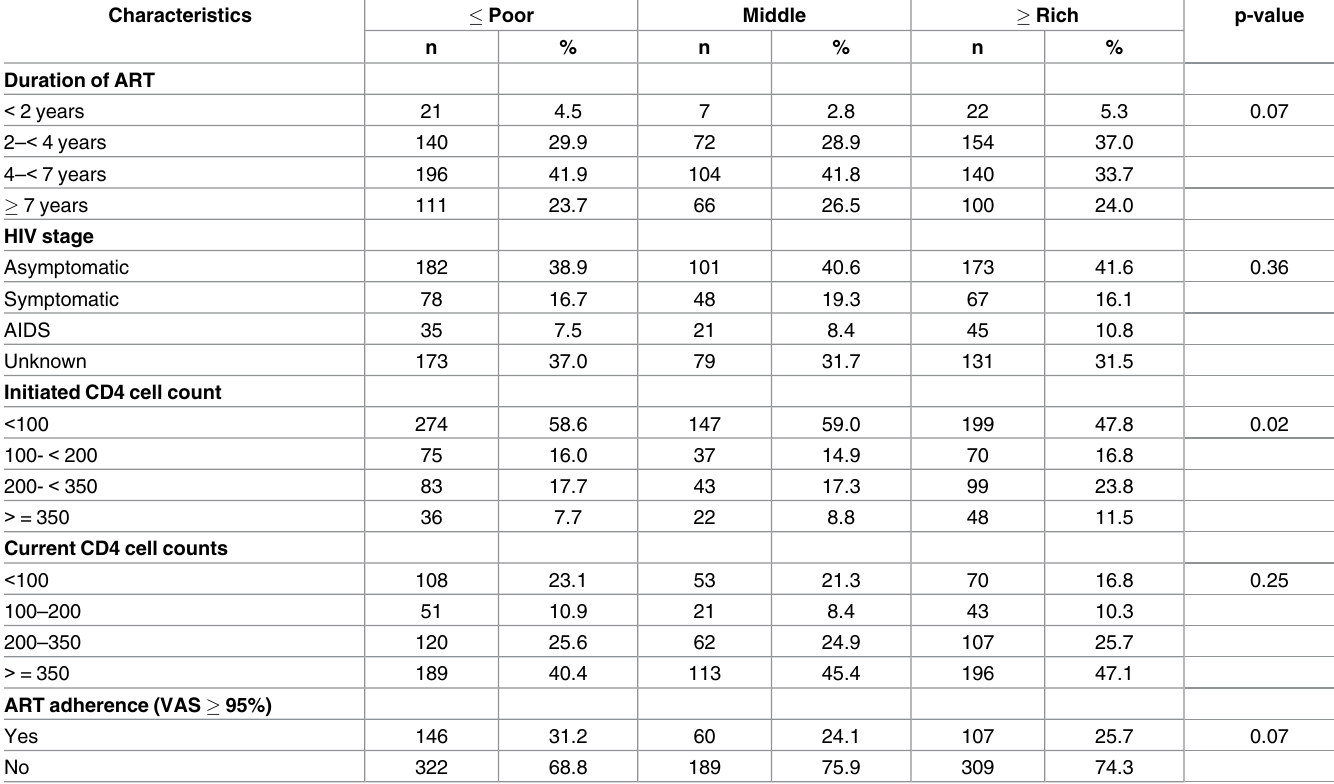
Table 2. ART access,adherence and outcome of respondents regarding to income quintiles.